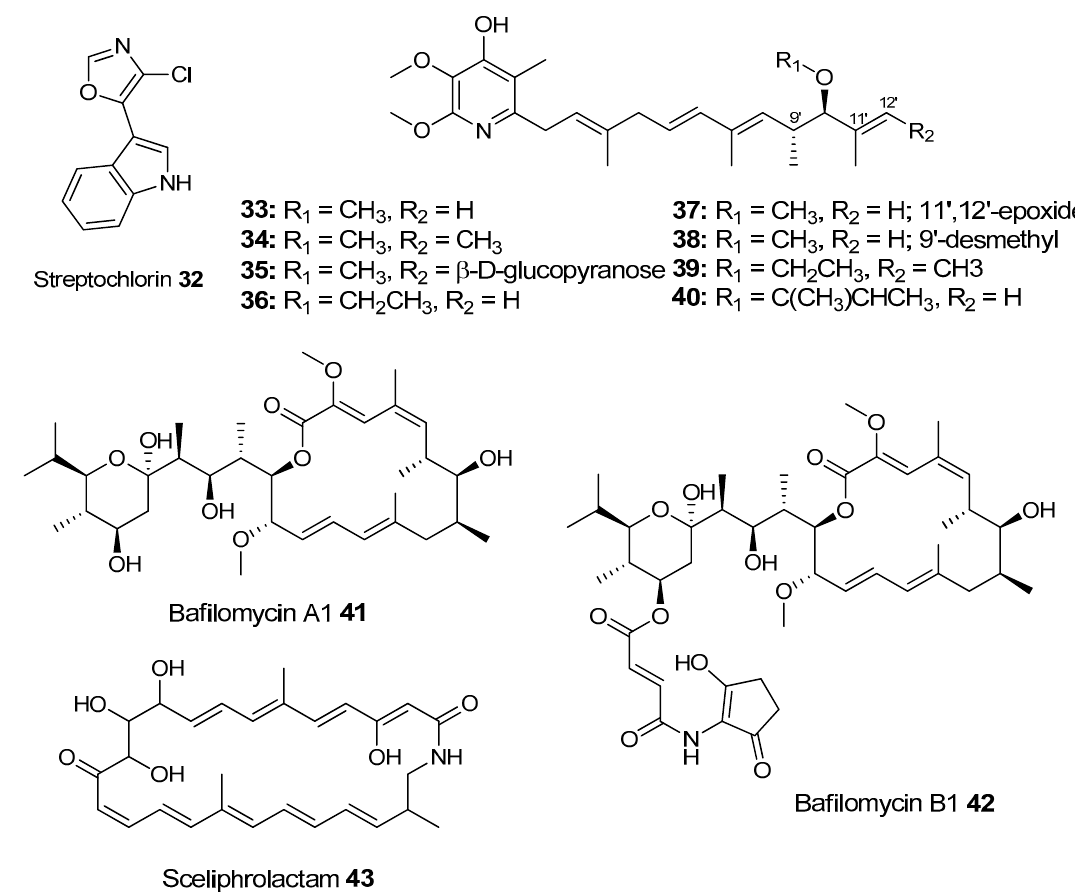
Figure 12. Bacterial secondary metabolites associated with non-social wasp species.